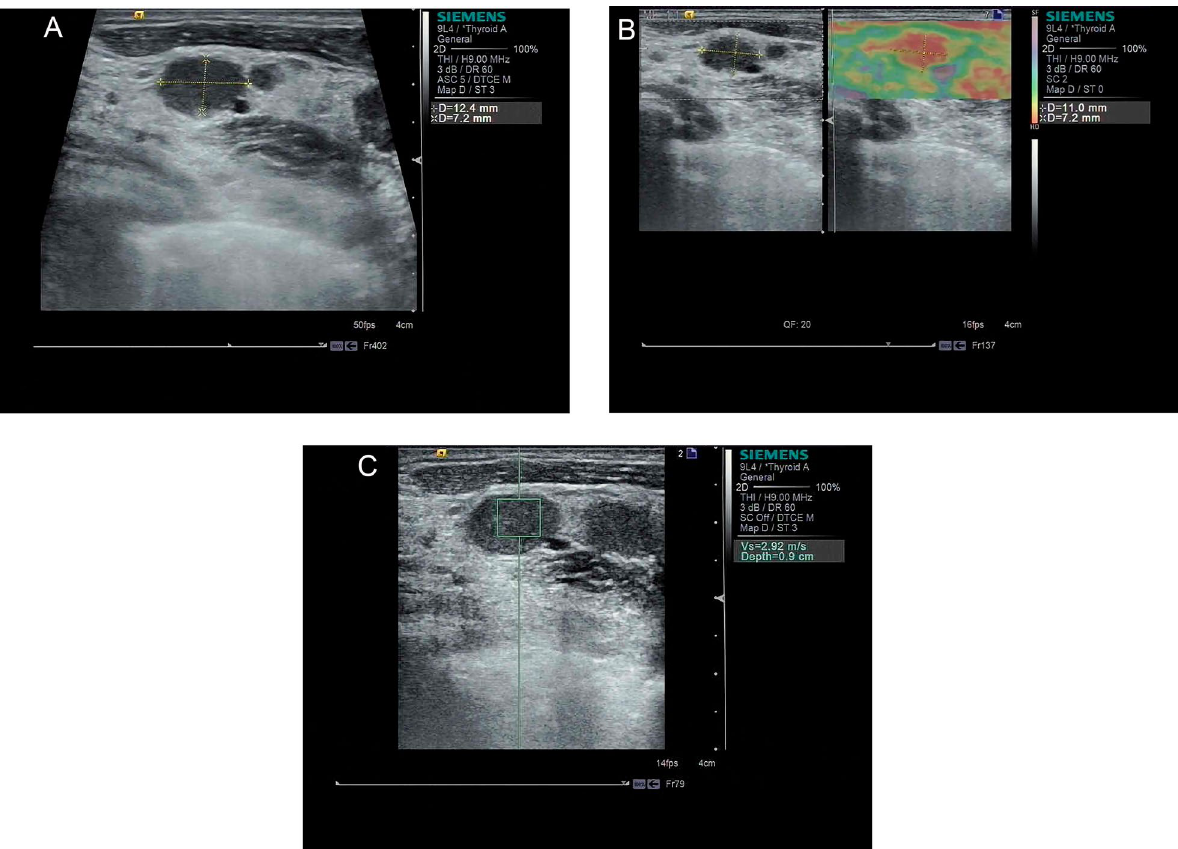
Fig. 4 Metastatic LN correctly diagnosed by SE and ARFI as being malignant. A Grayscale US image of small cervical LN with long/short axis < 2 and lost hilum. B SE image total red area more than 90% consistent with elasticity scale 4. C ARFI showed SWV of 2.92